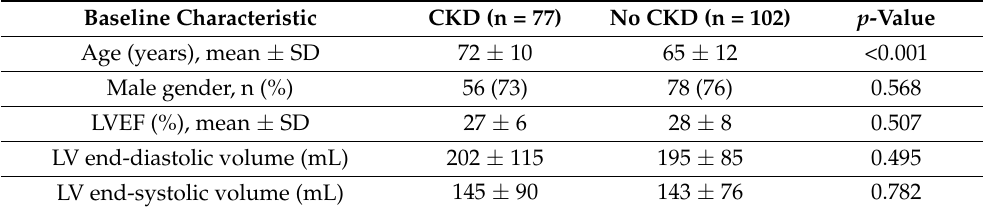
Table 1. Demographic, clinical, and therapeutic characteristics of patients at baseline (before S/V therapy). Baseline